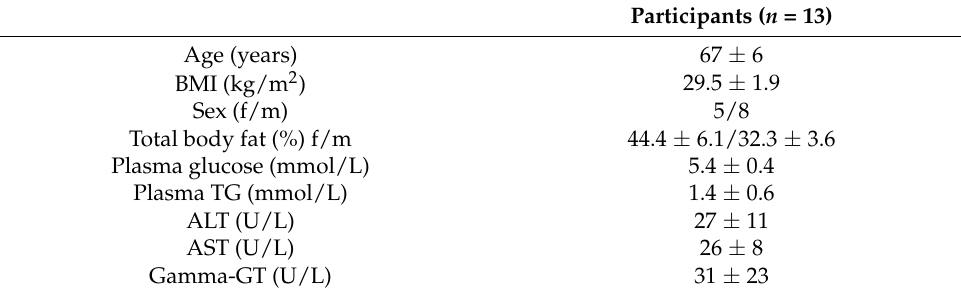
Table 1. Subject